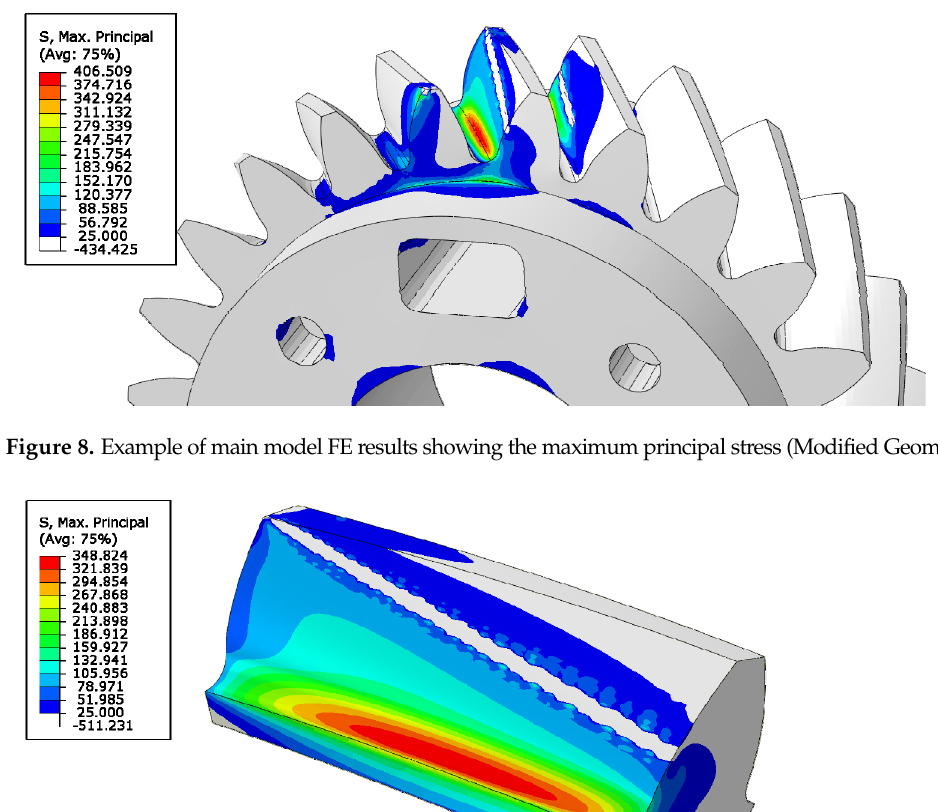
Figure 9. Example of sub-model FE results showing the maximum principal stress (Modified Geometry).